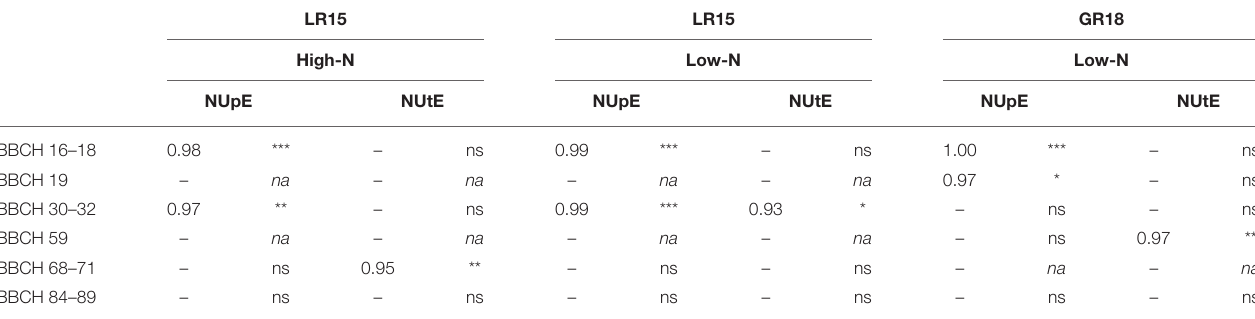
TABLE 4 | Correlation analysis between dry-matter-based N use efficiency (NUE_DM) and N uptake Efficiency (NUpE) or N Utilization Efficiency (NUtE) under low-N and high-N conditions during the crop